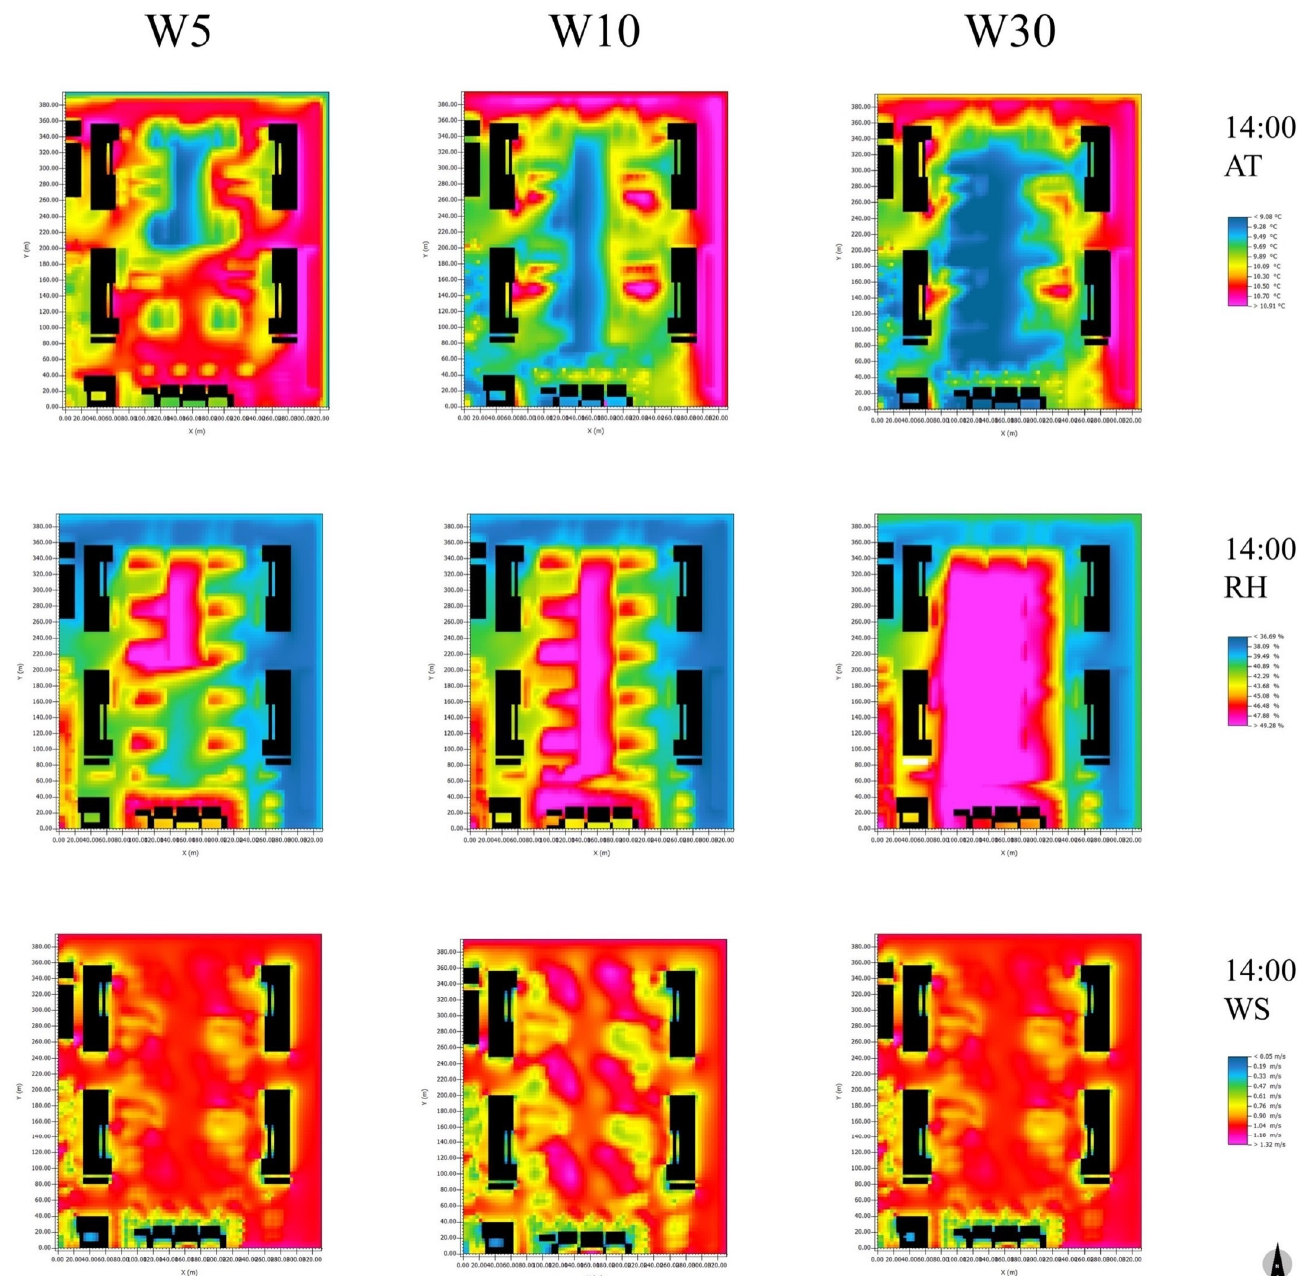
Figure 7. Distribution maps of microclimate parameters at 14:00 with redesigned water body